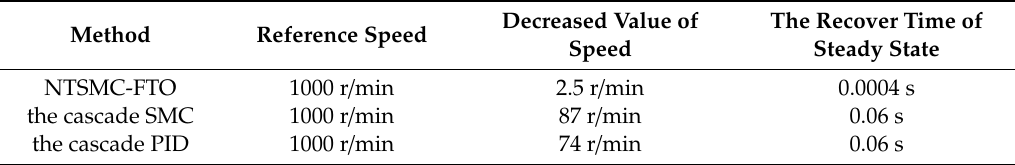
Table 6. The comparative simulation results of load changed